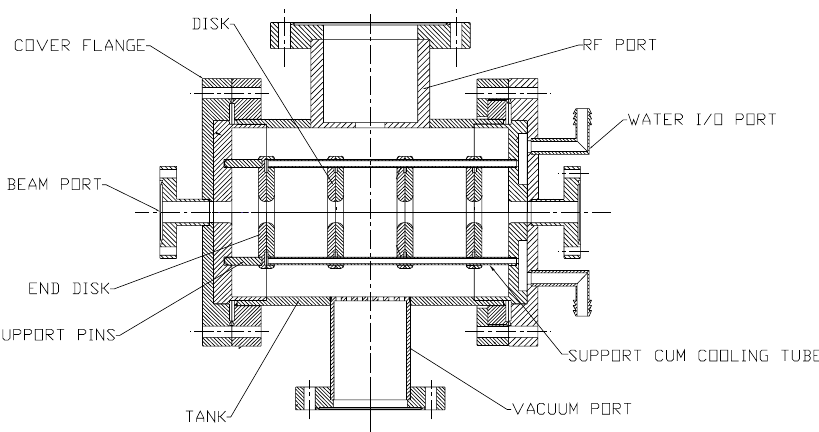
FIG. 1. Schematic of the prototype, 4-cell, PWT linac structure.